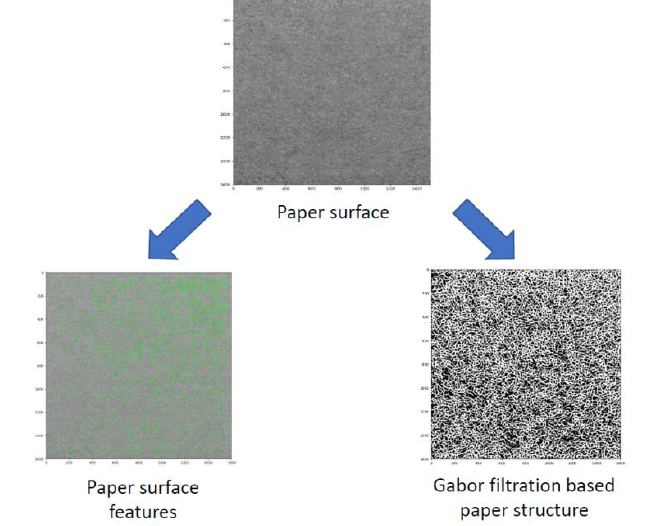
Figure 1. Paper surface features and structure